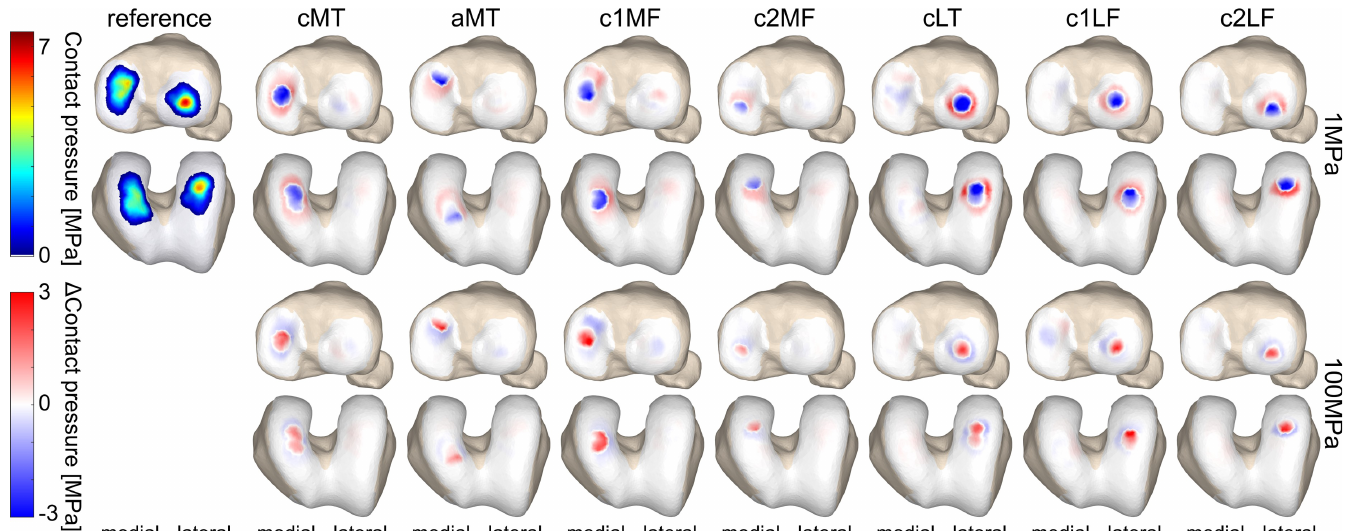
Fig 4. The effect of defect location on the local load distribution in the tibiofemoral joint. The average contact pressure distribution of a representative sample throughout the stance phase of gait is shown, as well as the difference pattern between the defect locations (columns) with an elastic modulus of 1MPa and 100MPa (rows) and the reference simulation. Only defect locations that presented significant differences in the average contact area and pressure at compartment level (Figs 1 & 3) are displayed. Red indicates more loading with respect to the reference simulation, blue indicates less loading with respect to the reference simulation.